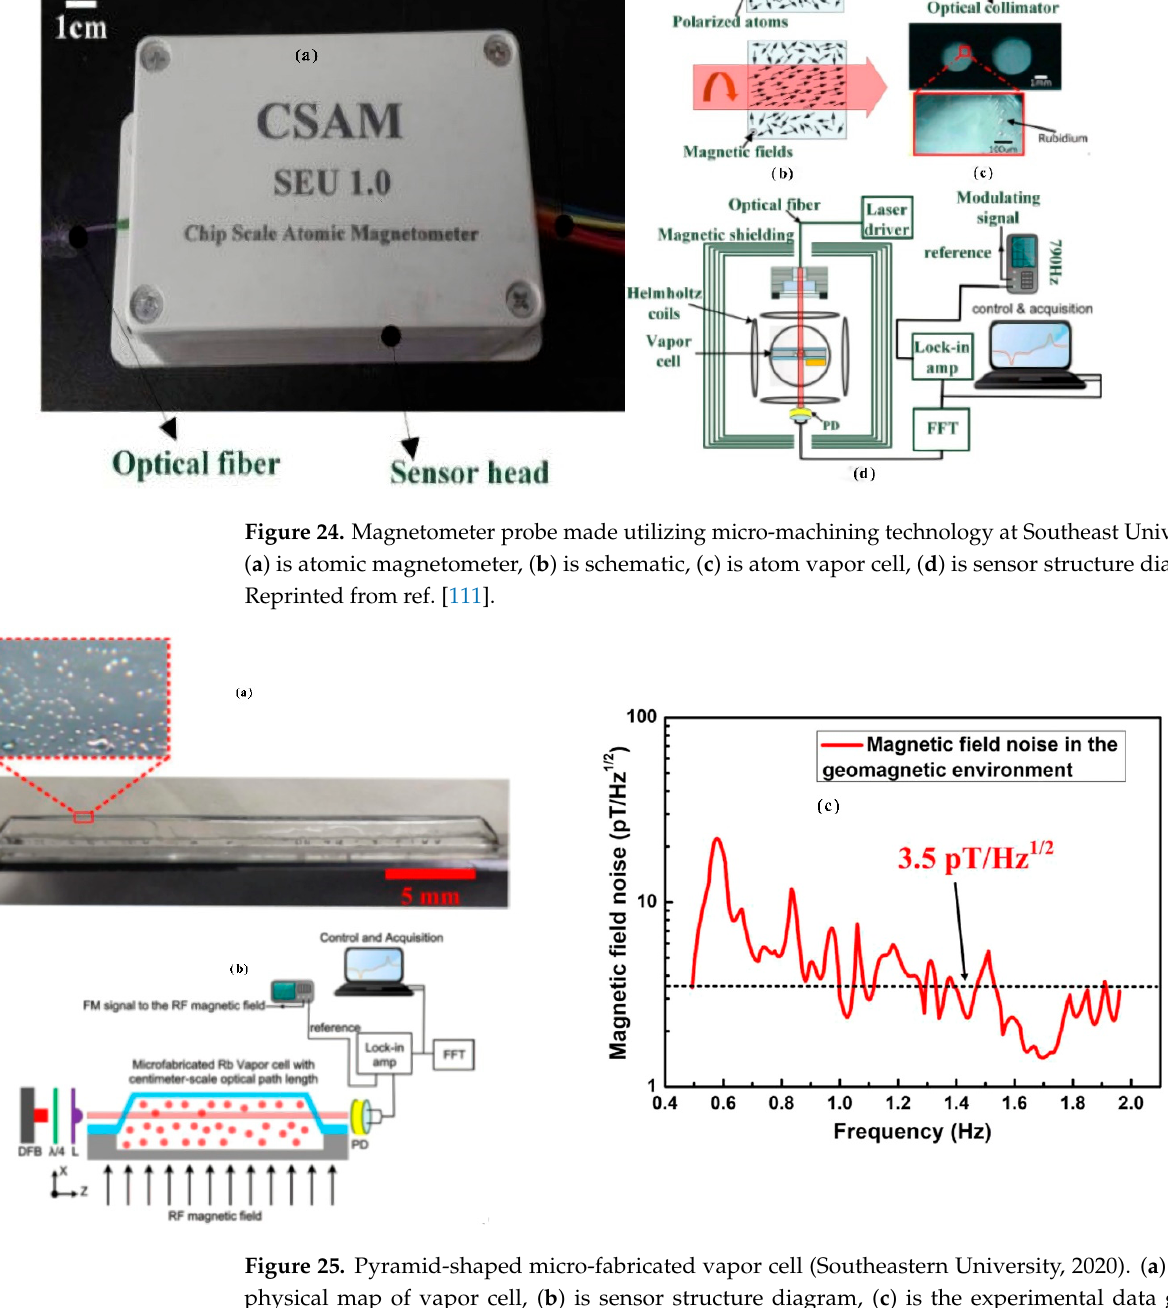
Figure 24. Magnetometer probe made utilizing micro-machining technology at Southeast Univer- sity. ( a ) is atomic magnetometer, ( b ) is schematic, ( c ) is atom vapor cell, ( d ) is sensor structure dia- gram. Reprinted from Ref [111].